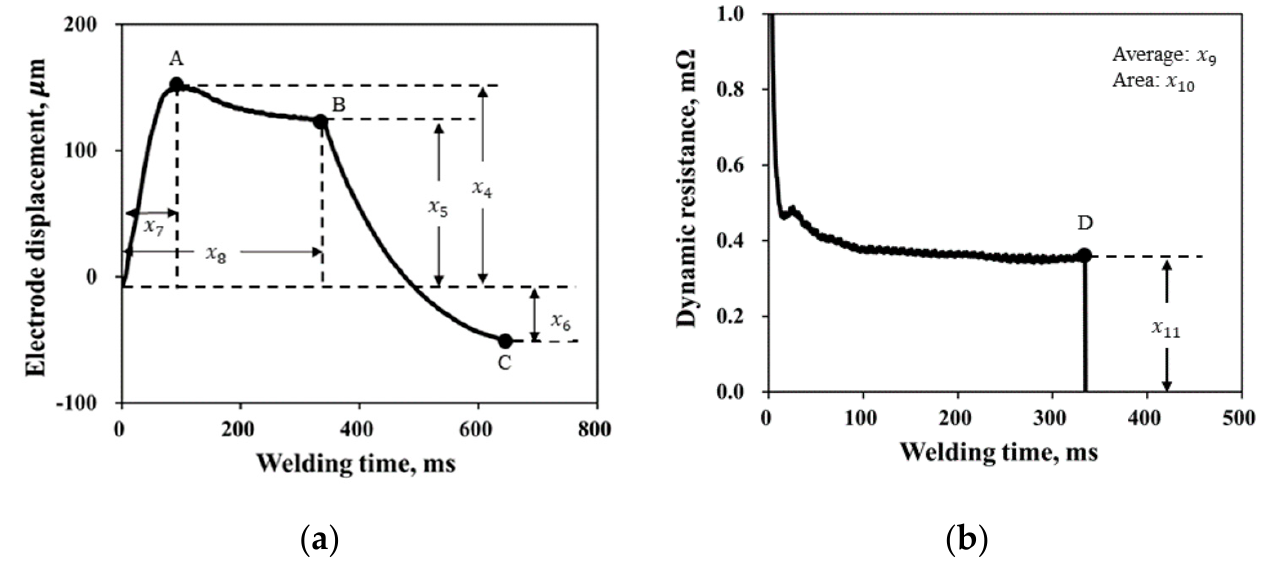
Figure 4. Independent variables of ( a ) electrode displacement and ( b ) dynamic resistance. Table 3 lists the 11 independent variables used to estimate the weld quality